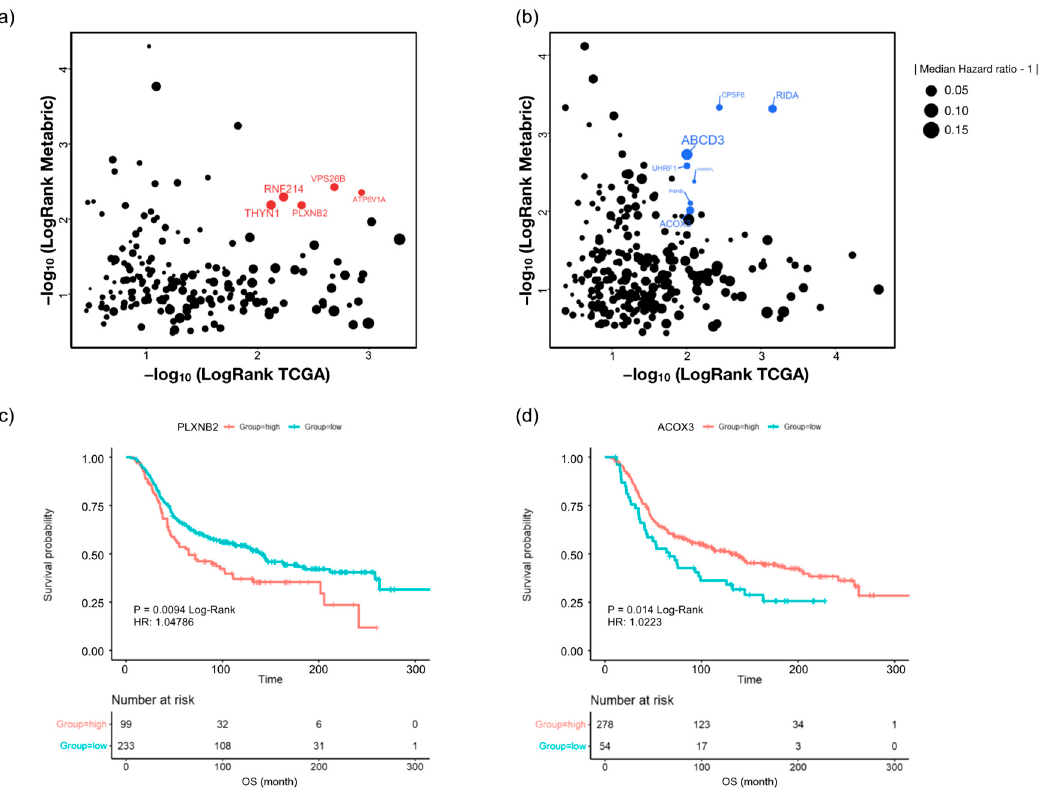
Figure 6. Relationships between drug-resistance-related proteins and overall survival (OS) in breast cancer patients. The log-rank test of overall survival rate of 194 upregulated proteins ( a ) and 294 downregulated proteins ( b ) in TCGA-BRCA pan-cancer ( x -axis) and Metabric cohorts ( y -axis). The highly significant log-rank p -value in both cohorts was indicated with red ( a ) and blue ( b ). Log-rank analysis of overall survival according to expression level of PLXNB2 ( c ) and ACOX3 ( d ) in patients treated with chemotherapy from Metabric. Table 2. Summary of 12 prognostic marker candidates . The Log 2 FC was calculated between paren- tal MCF-7 and drug-resistant cells using TMT 6-plex data.